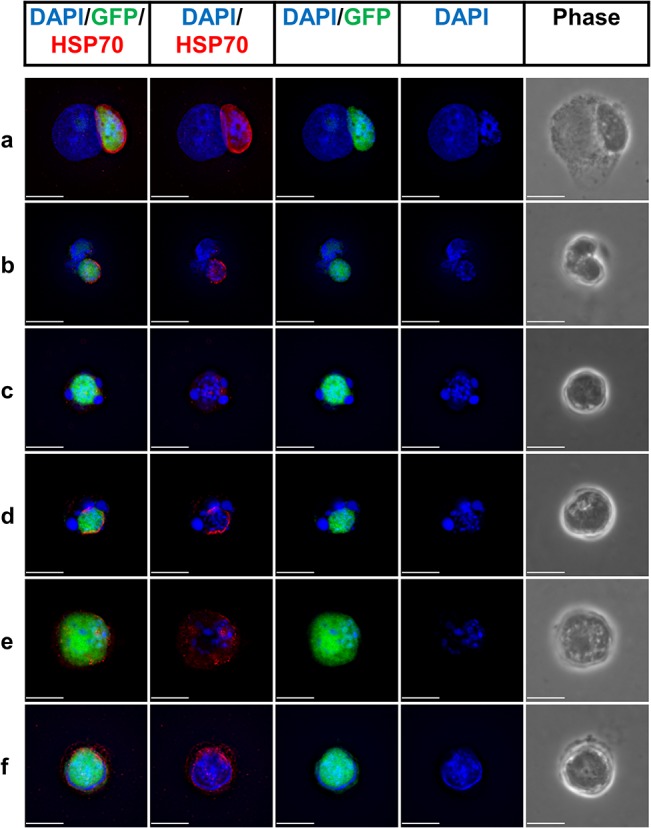
Visualization of parasites in HC-04 cells infected with P. falciparum.GFP-positive PI-negative events were isolated by flow cytometry-based cell sorting 96 hours postinfection and cytospun. Representative micrographs of EEFs show DNA staining with DAPI, GFP expression and immunofluorescent detection of PfHsp70 by anti-Hsp70 monoclonal antibody (Blue = DAPI, Green = GFP, Red = PfHsp70. Scale bars indicate 10 μm).